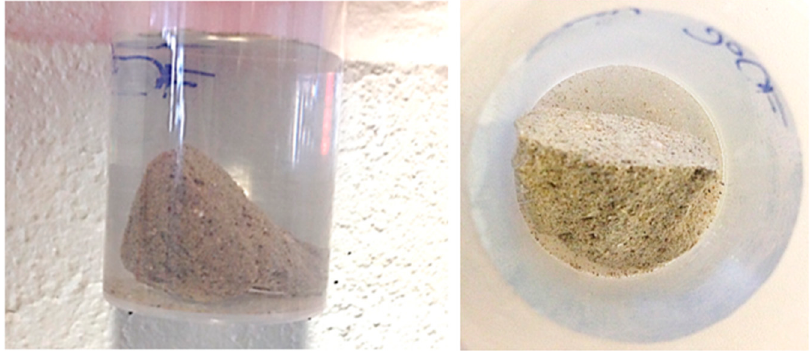
Figure 4. Water stability of one-part alkali activated mortars after 3 months of immersion.